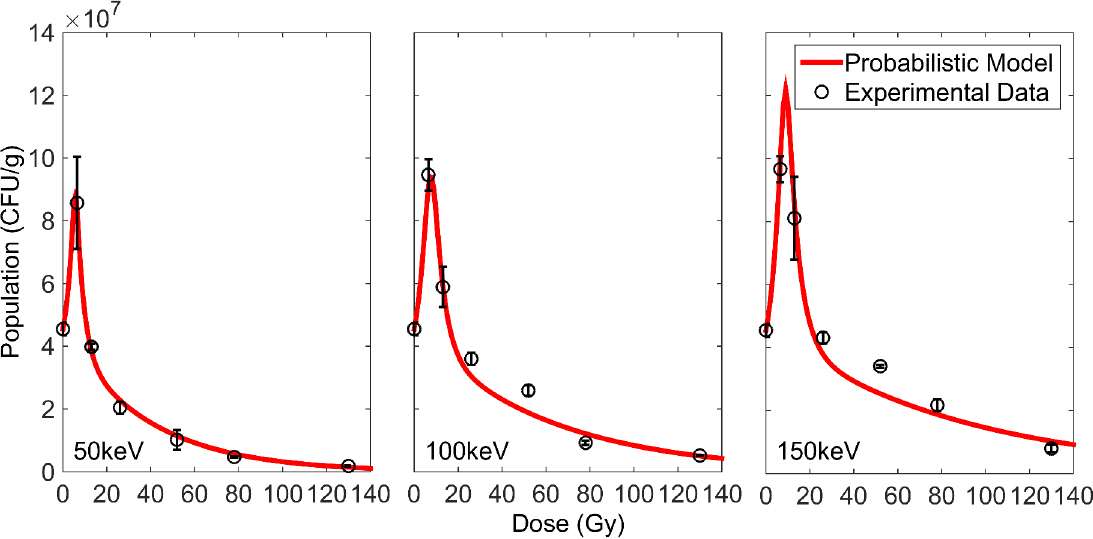
Fig 4. Activation and inactivation curves of Bacillus pumilus spores irradiated by X-rays of different cut-off energies. Fitted curves were obtainedfrom the probabilisticmodel.